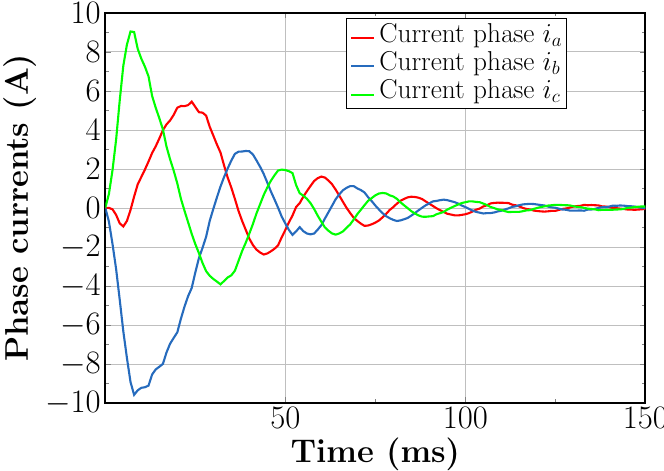
Figure 17. Sensorless speed control for 1200 RPM, stator three-phase currents.